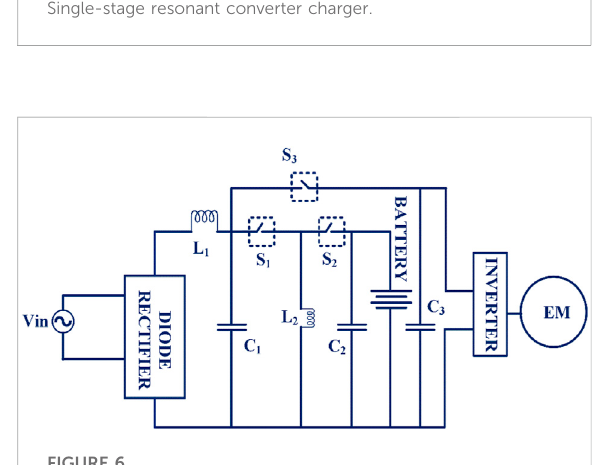
FIGURE 5 Single-stage resonant converter charger.